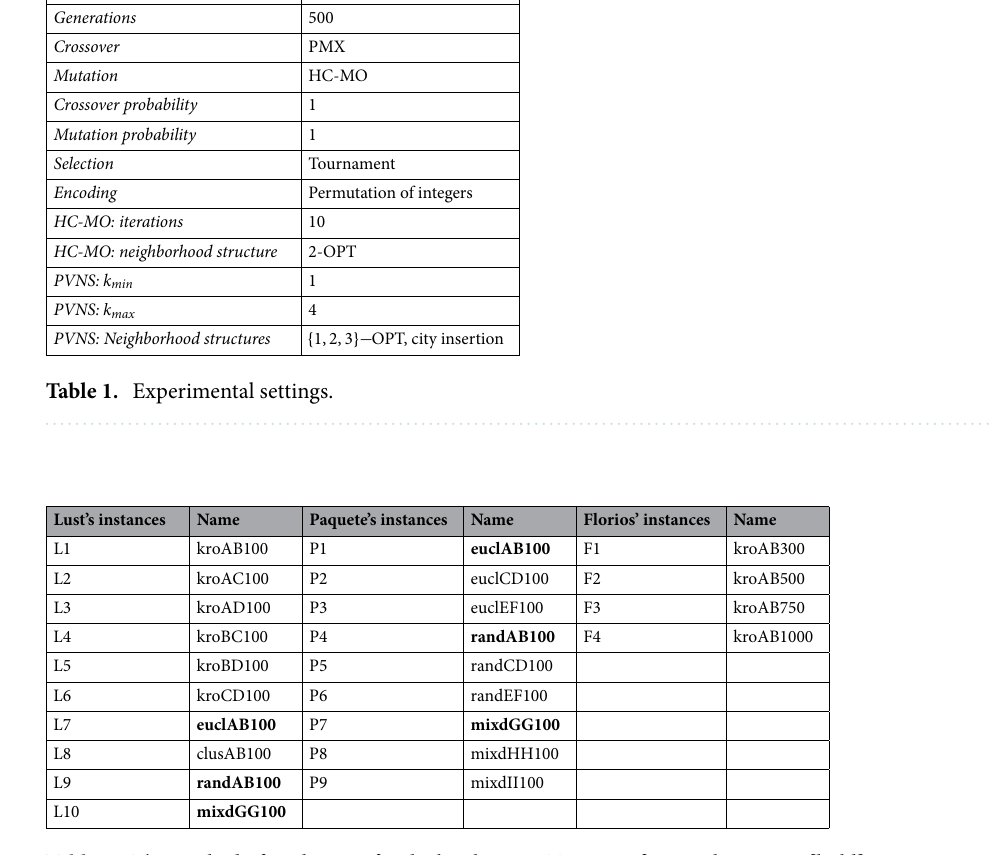
Table 2. The test bed of 16 datasets for the bi-objective TSP. Significant values are in